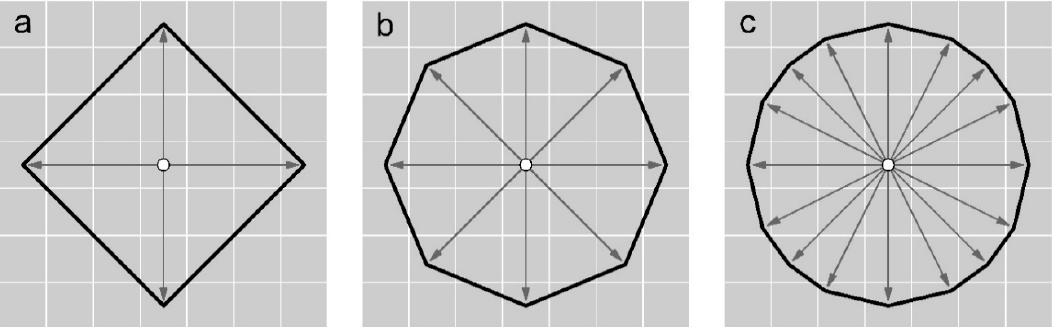
Figure 5. Raster geographic information systems (GIS) simulated travel directions (gray arrows) from a starting point (white circle) in ( a ) four directions, ( b ) eight directions, and ( c ) 16 directions, and the resulting polygon shapes representing the optimal travel distance (black lines).